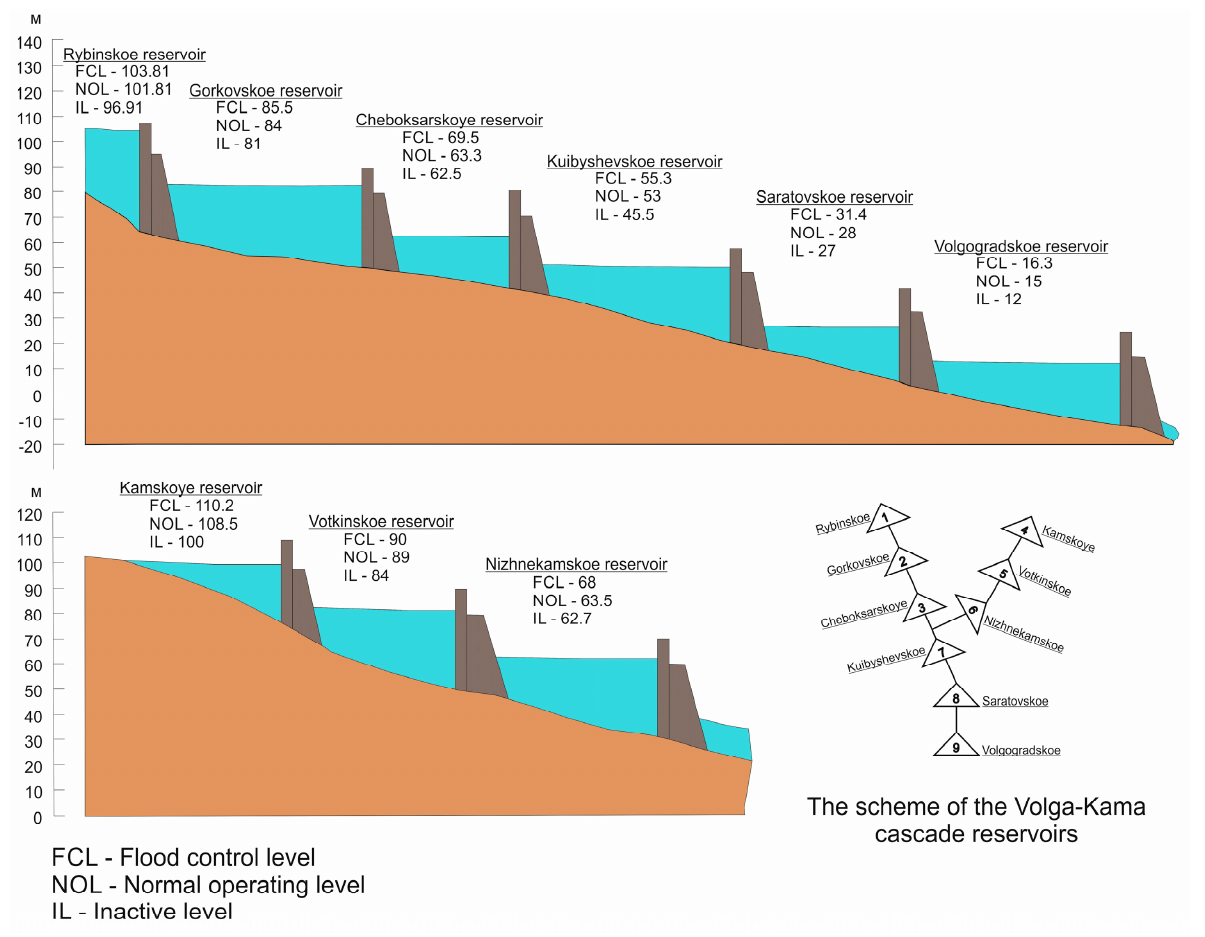
Figure 1. Calculation scheme of the Volga–Kama cascade of reservoirs.